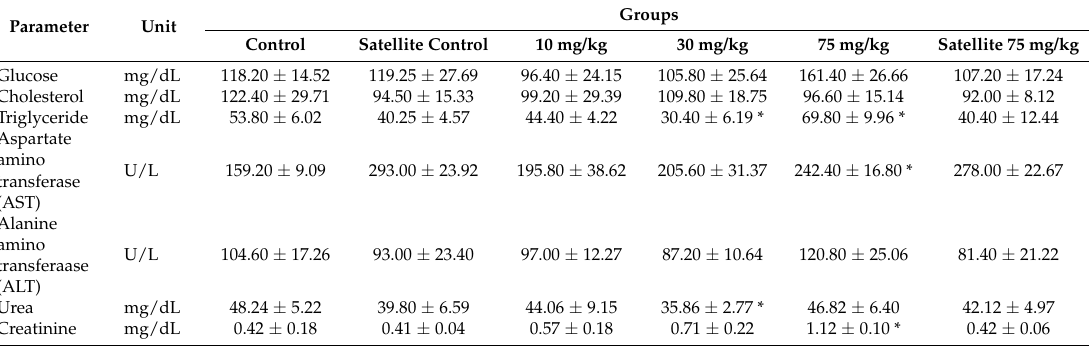
Table 6. Biochemical profile of female rats treated with different doses of the film formulation for 28 days.